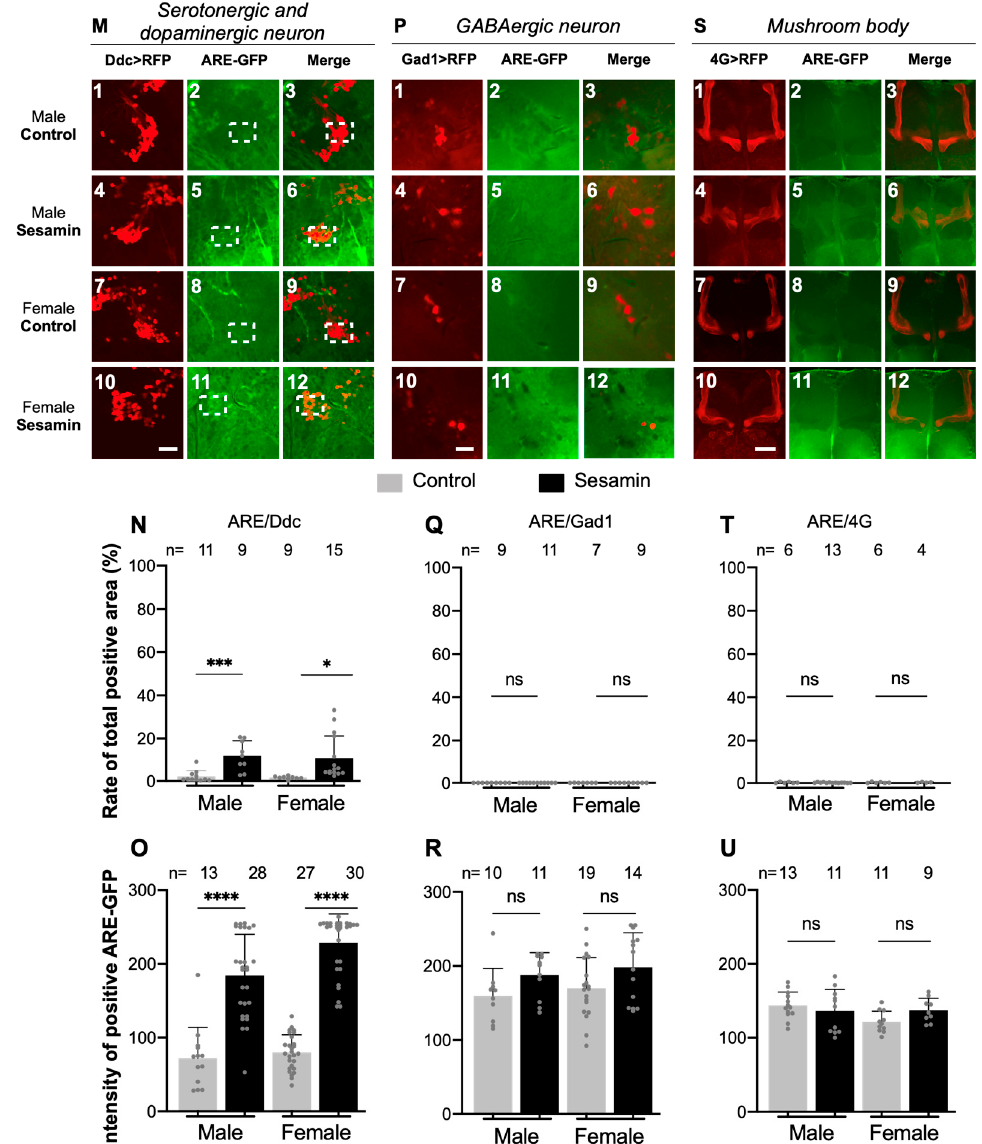
Figure 3. Expression of ARE-dependent transcription by Nrf2/Cnc in several types of neurons in the central adult brain. ( A , E , I , M , P , S ) Confocal microscopy observation of GFP fluorescence monitoring ARE-dependent transcription by Nrf2/Cnc transcription factor in five types of neurons and mushroom bodies in brains from adults fed on sesamin. The glutamatergic neurons ( A – D ), cholinergic neurons ( E – H ), dopaminergic neurons ( I – L ), serotonergic and dopaminergic neurons ( M – O ), GABAnergic neurons ( P – R ), and mushroom bodies ( S – U ) were labelled by RFP using VGlut-Gal4 ( VGlut > RFP ), ChAT-Gal4 ( ChAT > RFP ), TH-Gal4 ( TH > RFP ), Ddc-Gal4 ( Ddc > RFP ), Gad1-Gal4 ( Gad1 > RFP ), and GawB-Gal4 ( 4G > RFP ) respectively. Images in ( A , E , I , M , P , S ) correspond to clusters of each type of neurons in brains from flies fed on the diet with 0.5% DMSO (control), or with 2 mg/mL sesamin in 0.5% DMSO (sesamin). Scale bars in ( A , E , M , P ) represent 10 µ m, a bar in I represents 20 µ m, and a bar in S represents 50 µ m. ( B , F , J ) The total area showing ARE-GFP fluorescence ( n ≥ 10). ( C , G , K , N , Q , T ) Ratios of the areas among ARE and RFP-positive areas in brains ( n ≥ 4) were calculated by ImageJ for each condition. ( D , H , L , O , R , U ) Intensity of the GFP fluorescence was calculated by ImageJ for each condition ( n ≥ 9). ns not significant, * p < 0.05, ** p < 0.01, *** p < 0.001, **** p < 0.0001, Student’s t -test.